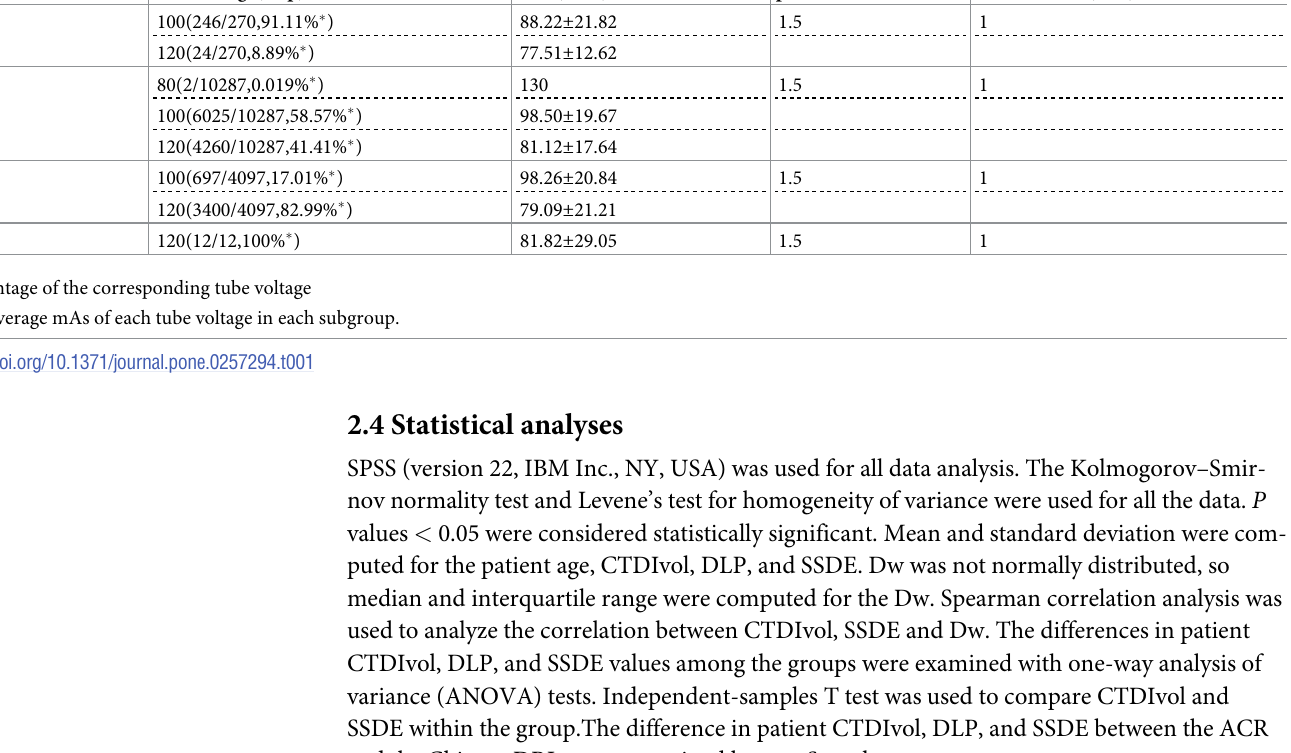
Table 1. Scan parameters of subjects in each group.